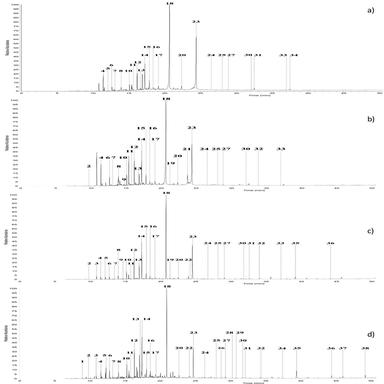
Total ion current chromatograms of samples 90002472(a), 90002475 (b), 90002486 (c) and 90002491 (d). All the compounds were identified as their TMS derivatives.